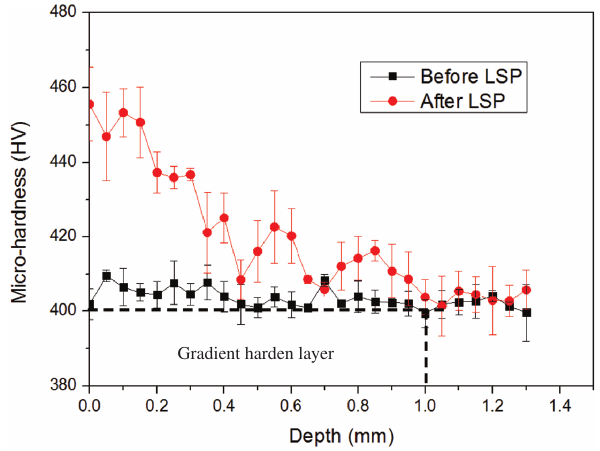
Figure 6: Microhardness of the sample before and after